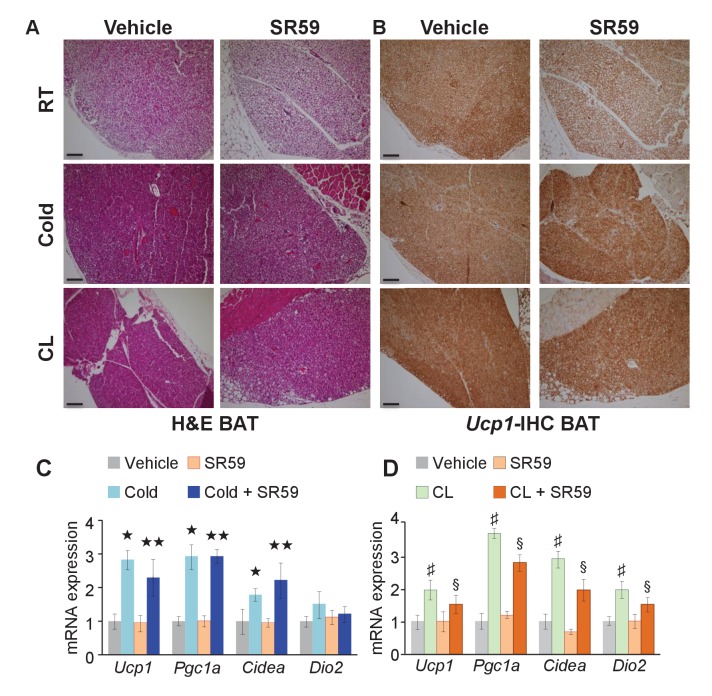
Inhibiting Adrb3 does not alter brown adipose tissue.(A) H&E staining of brown adipose tissue (BAT) from mice treated with vehicle or SR59 maintained at room temperature, cold exposed or CL treated for seven days. (B) Ucp1 IHC of BAT from mice described in (A). (C) mRNA expression of BAT genes from mice described in (A) cold exposed. ★p<0.01 cold exposed to room temperature vehicle-treated mice. ★★p<0.05 cold+SR59 compared to vehicle room temperature-treated mice. (D) mRNA expression of BAT genes from mice described in (A) treated with CL. ♯ p<0.01 CL-treated compared to vehicle-treated mice. §p<0.01 CL+SR59-treated compared to vehicle-treated mice. All data are means ± SEM. Scale bar = 100 µm.